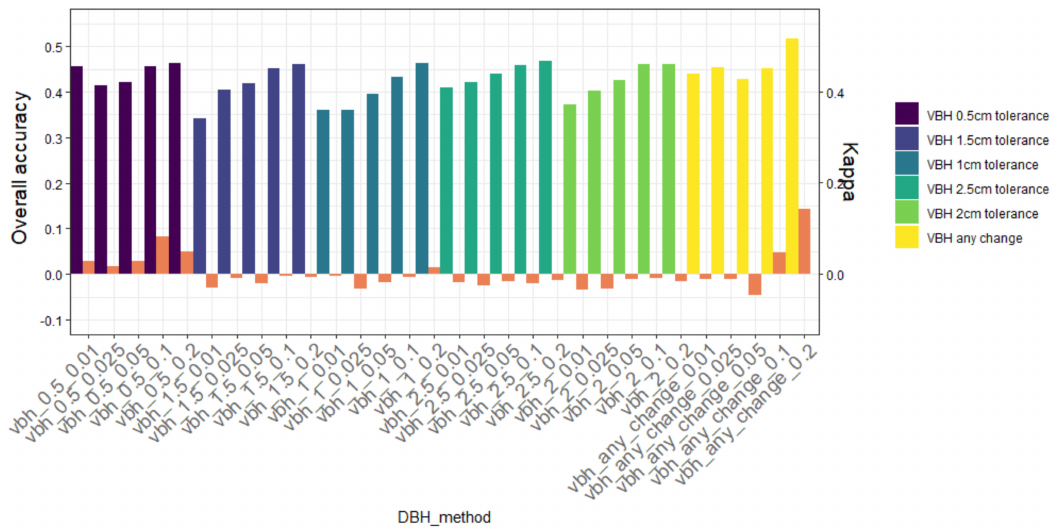
Figure 12. Accuracy and Kappa values for each of the VBH tunings that were assessed. Coloured bars represent overall accuracy of each tuning, coloured by the tuning of the tolerance; orange bars represent the kappa coefficient for each